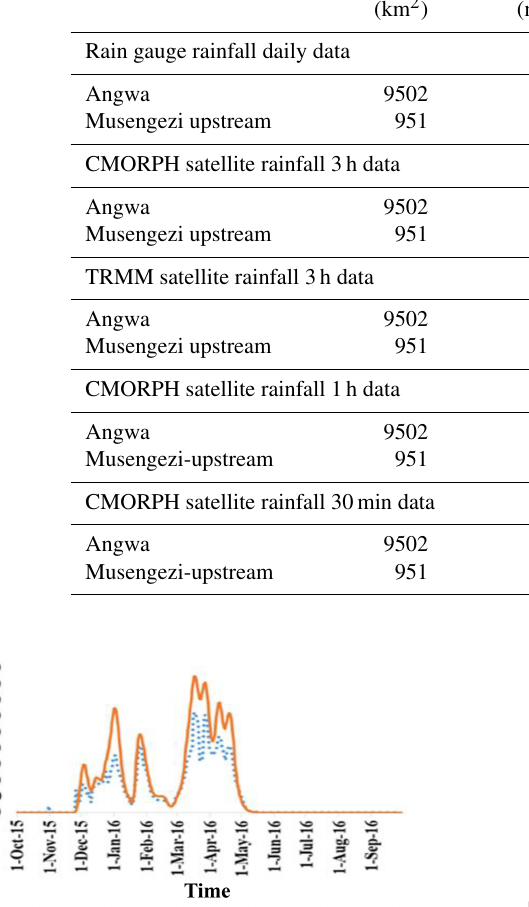
Figure 5. Comparison of area of inundation for two satellites on different time